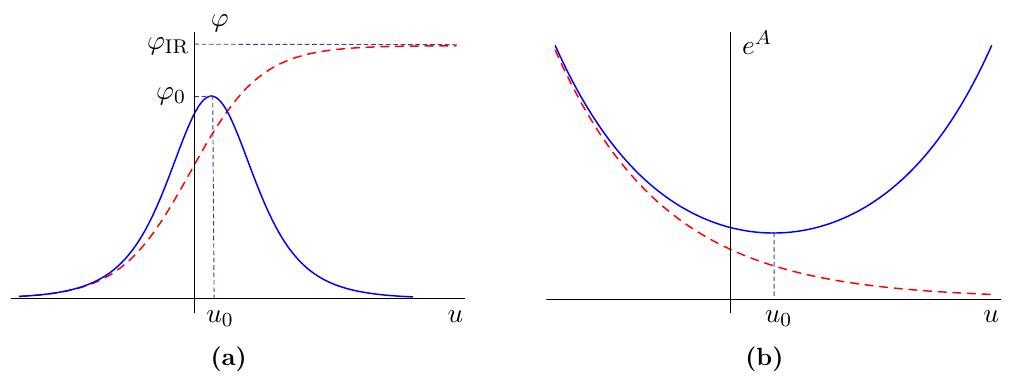
Figure 3. The solid lines show the scalar (cid:12)eld (left) and scale factor (right) pro(cid:12)les of a negative curvature RG (cid:13)ow geometry, from the left boundary ( u ! (cid:0)1 , ’ ! 0) to the turning point ( u = u 0 , ’ = ’ 0 ), to the right boundary ( u ! + 1 , ’ ! 0). The solution is symmetric around u 0 . The dashed lines represent the zero-curvature solution interpolating from the UV boundary to the IR (cid:12)xed point at ’ = ’ IR , and featuring a monotonic scale factor. IR limit (section